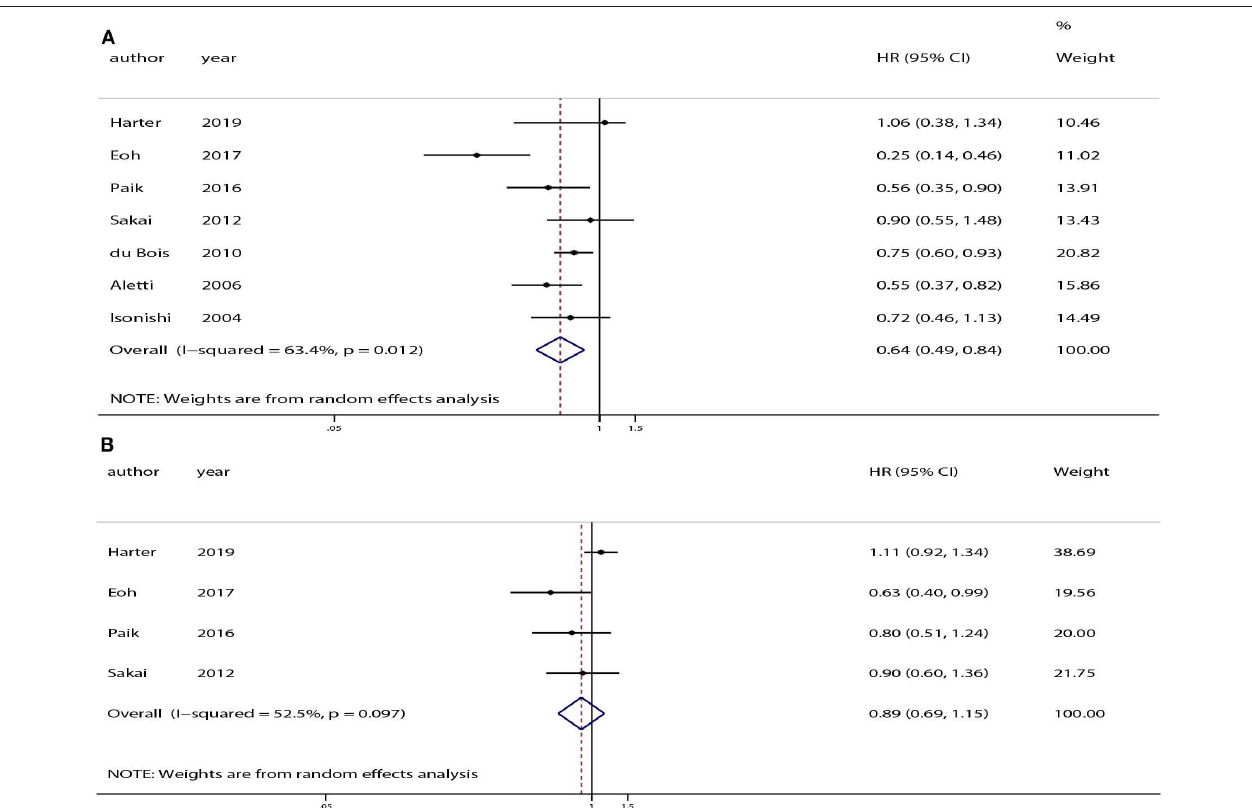
FIGURE 2 | Overall analyses of systematic lymphadenectomy vs. unsystematic lymphadenectomy for advanced ovarian cancer patients. (A) Overall survival (OS). (B) Progression-free survival (PFS).